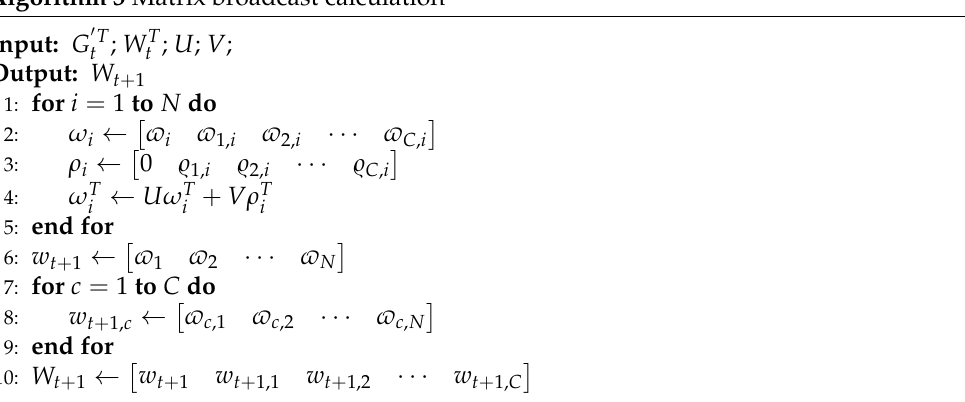
Algorithm 3 Matrix broadcast